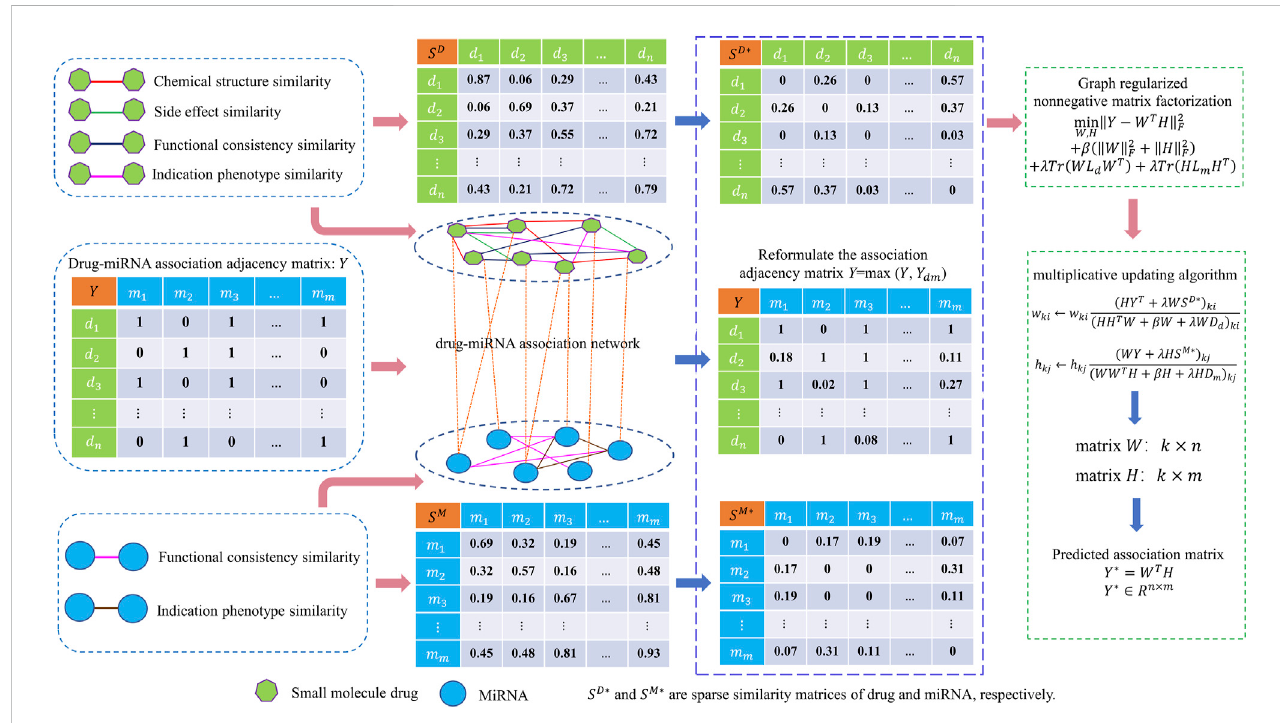
FIGURE 1 Overall framework of GNMFDMA for inferring potential drug-miRNA associations.